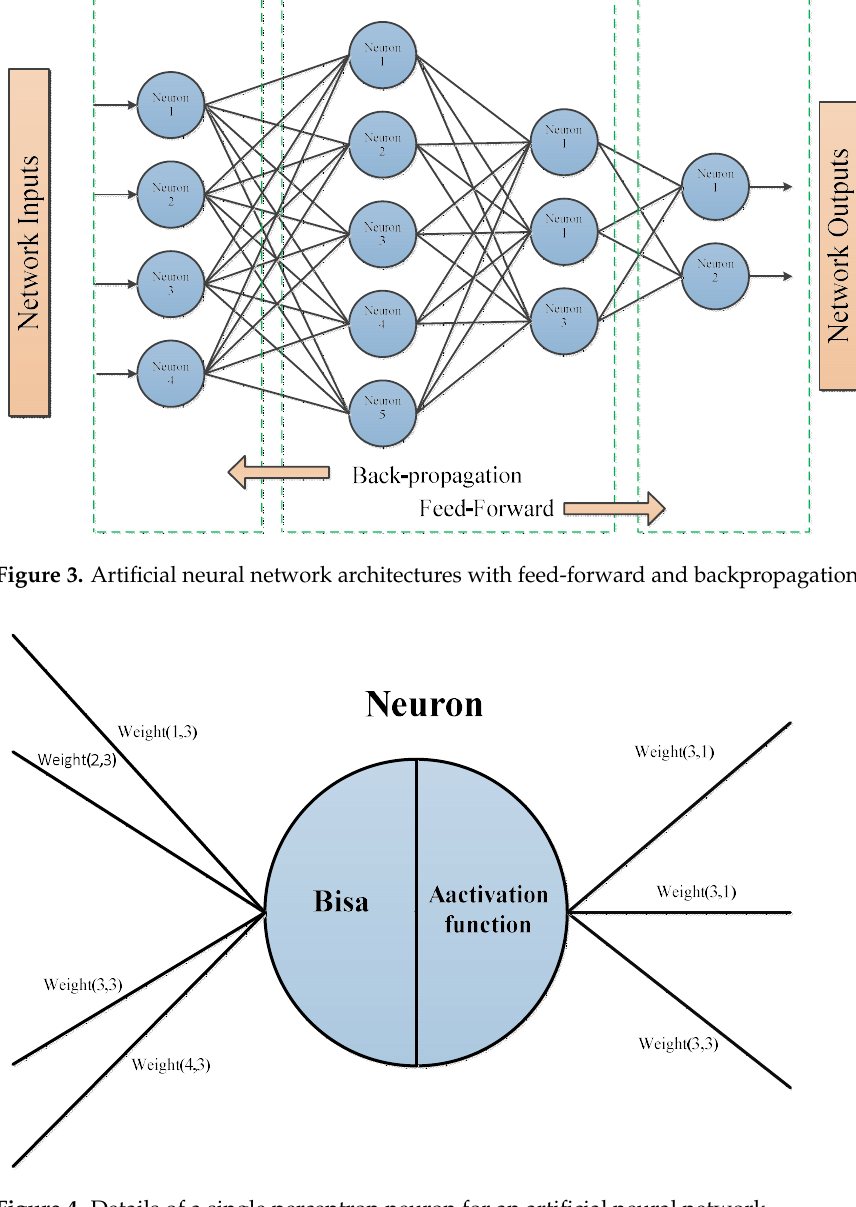
Figure 4. Details of a single perceptron neuron for an artificial neural network.